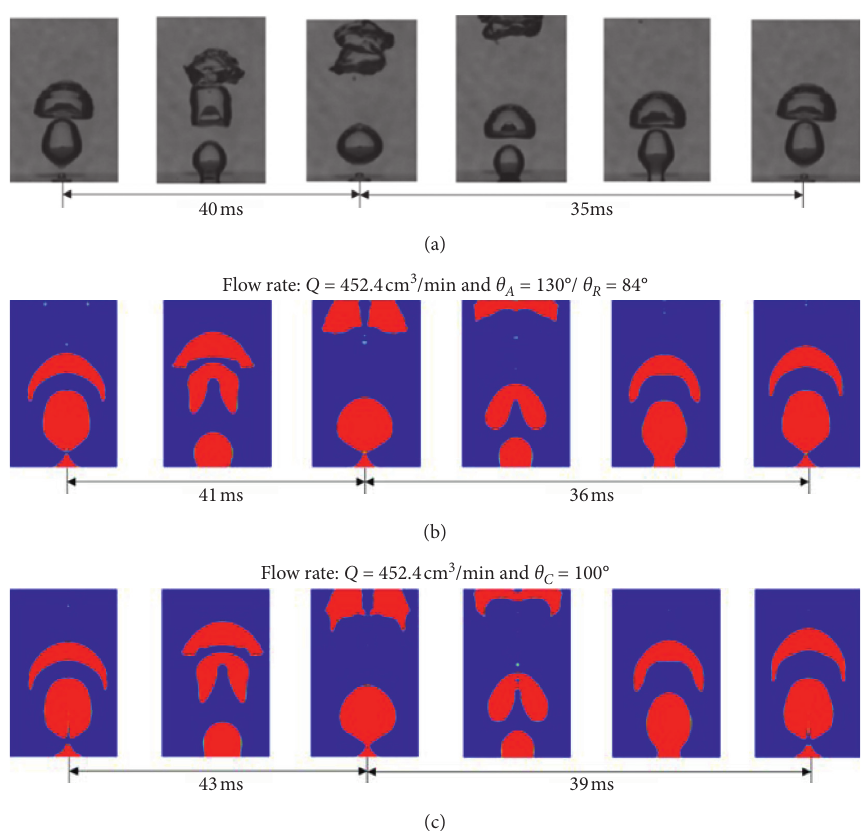
Figure 9: Snapshot comparison of bubble formation ( Q � 452.4cm 3 /min, Re � 164.30, and d (b) results of dynamic contact angle model simulation ( θ A � 130 ° and θ R � 84 ° ); (c) results of static contact angle model simulation ( θ C � 100 ° ).